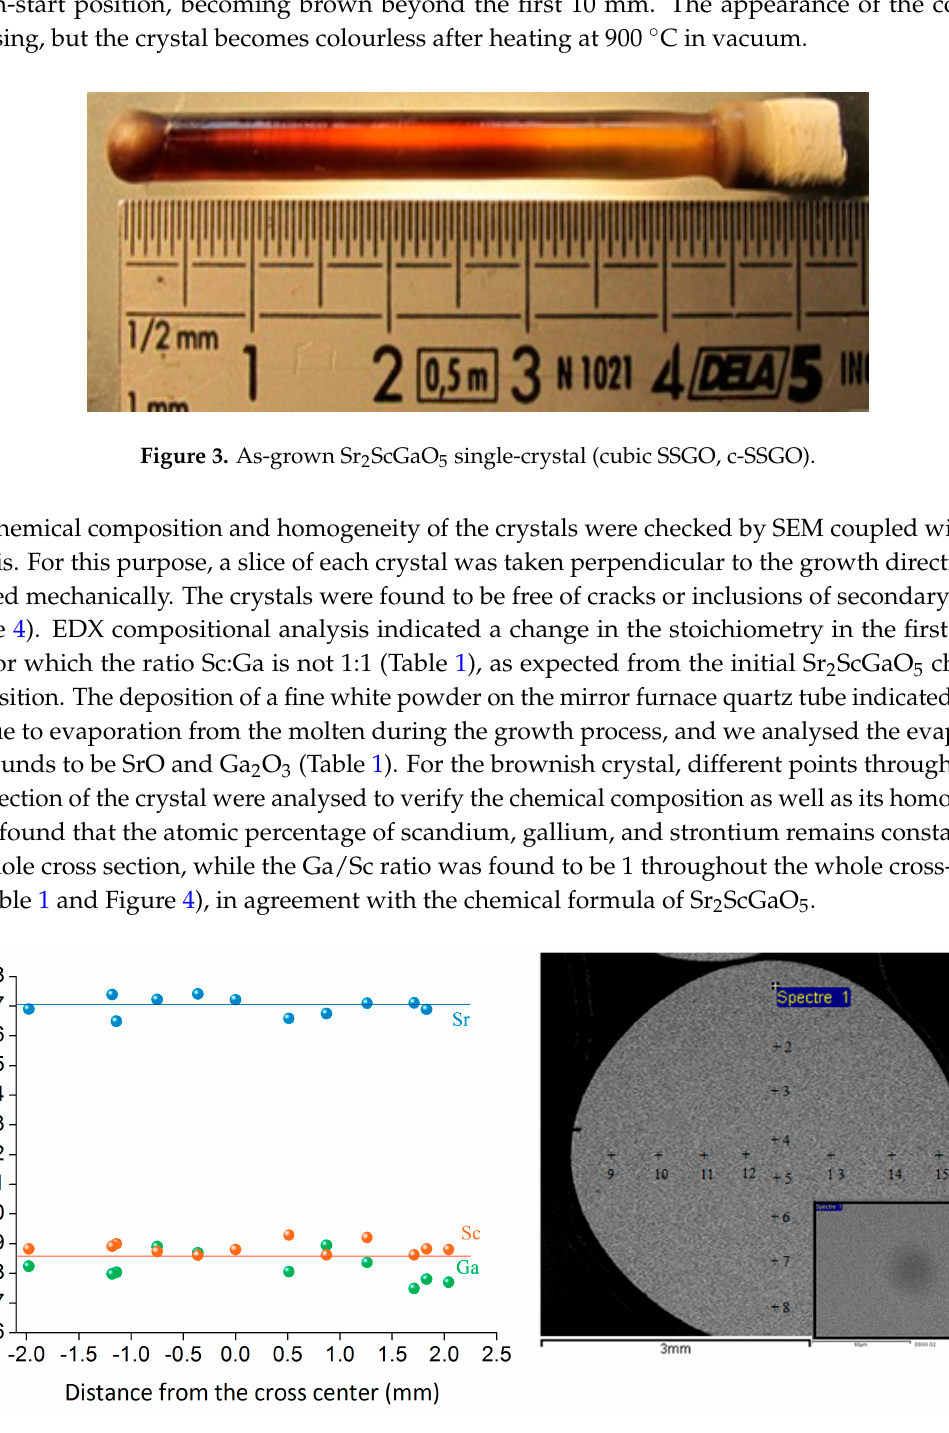
Figure 4. Chemical composition along the cross section of the as as-grown c-SSGO single crystal ( left ). ( right ) SEM cross section and analysed points.